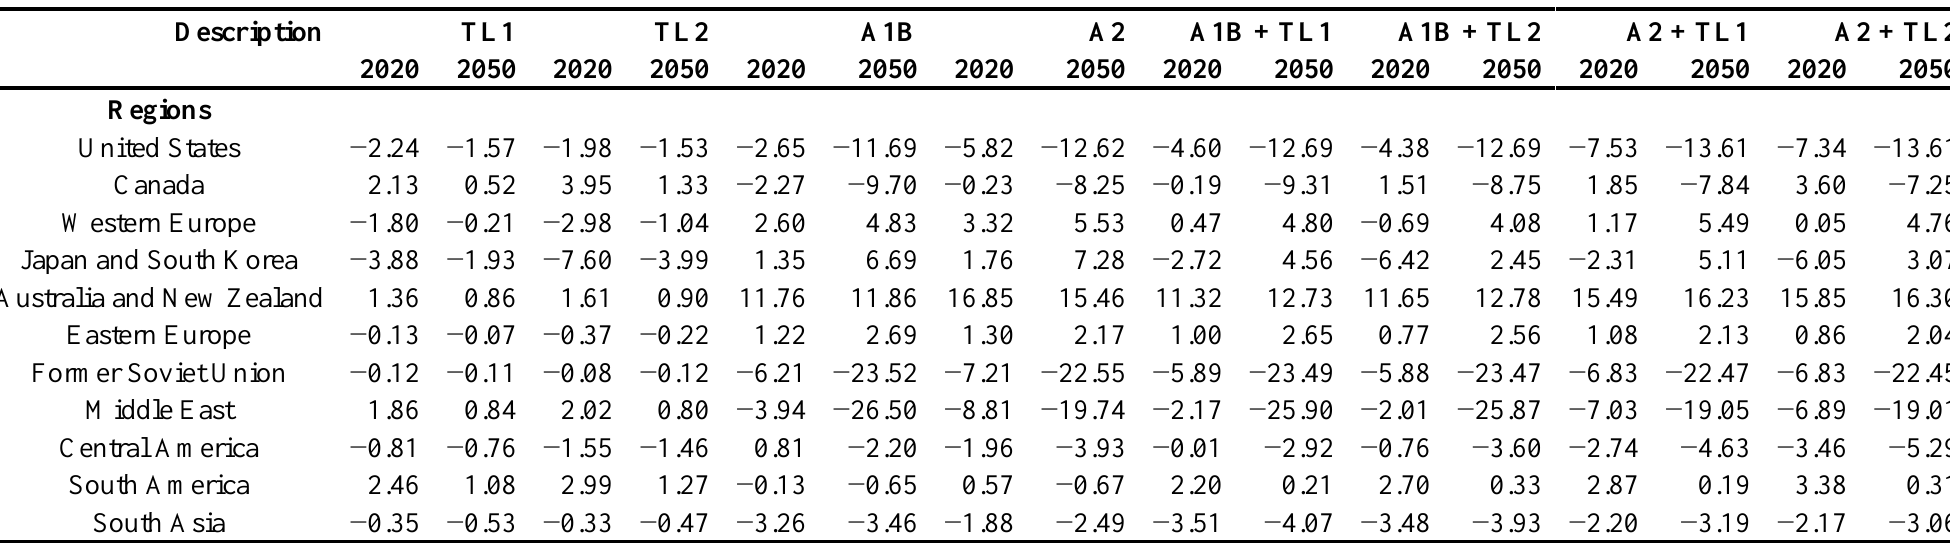
Table B4. Change in agricultural water use in 2020 and 2050 (in %) relative to